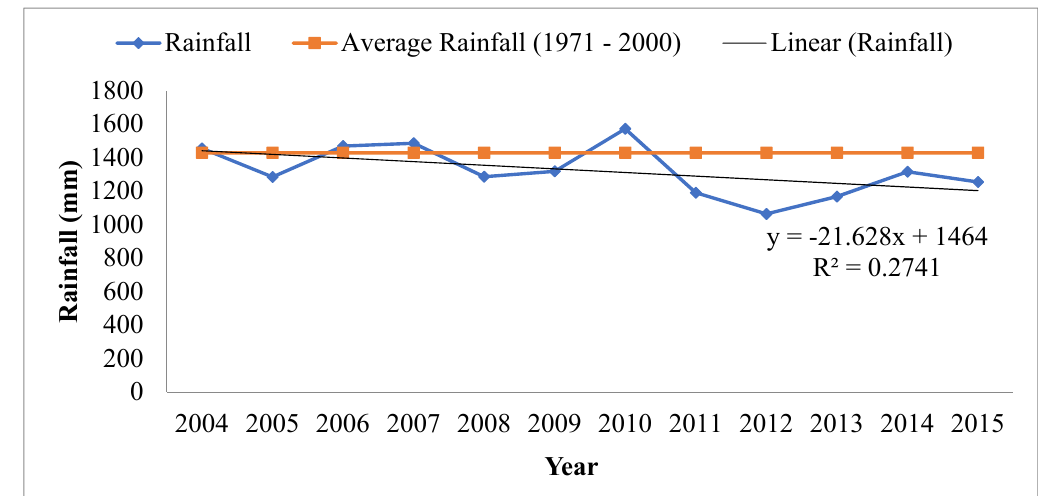
Figure 2. Annual rainfall (mm) in Ejura-Sekyedumase Municipality (2004–2015); NB: average annual rainfall (1971–2000) for the municipality is 1430.0 mm.